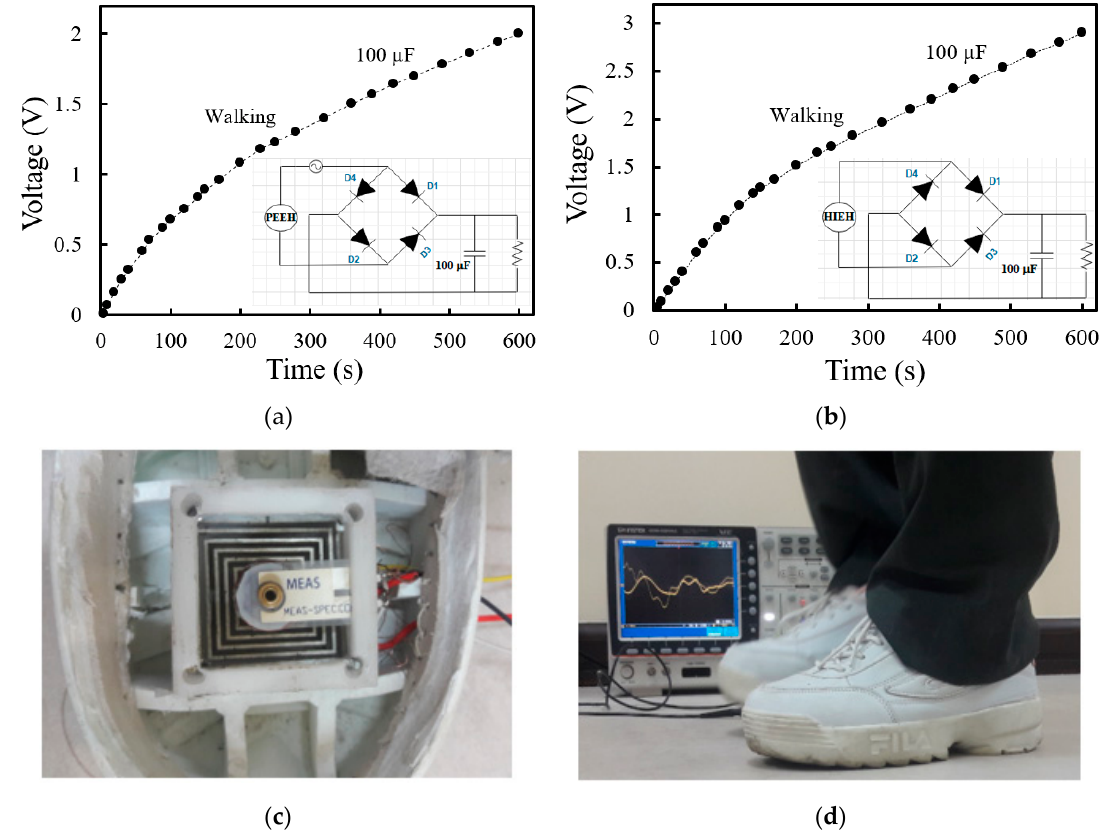
Figure 10. ( a ) Voltage curve showing 100 µF capacitor, charged by the piezoelectric part of the harvester. ( b ) A capacitor charged by the hybrid piezoelectric and electromagnetic harvester. ( c ) Photograph of the HIEH incorporated into the sole of a commercial shoe, and ( d ) voltage generation is shown in the oscilloscope with footstep fall.